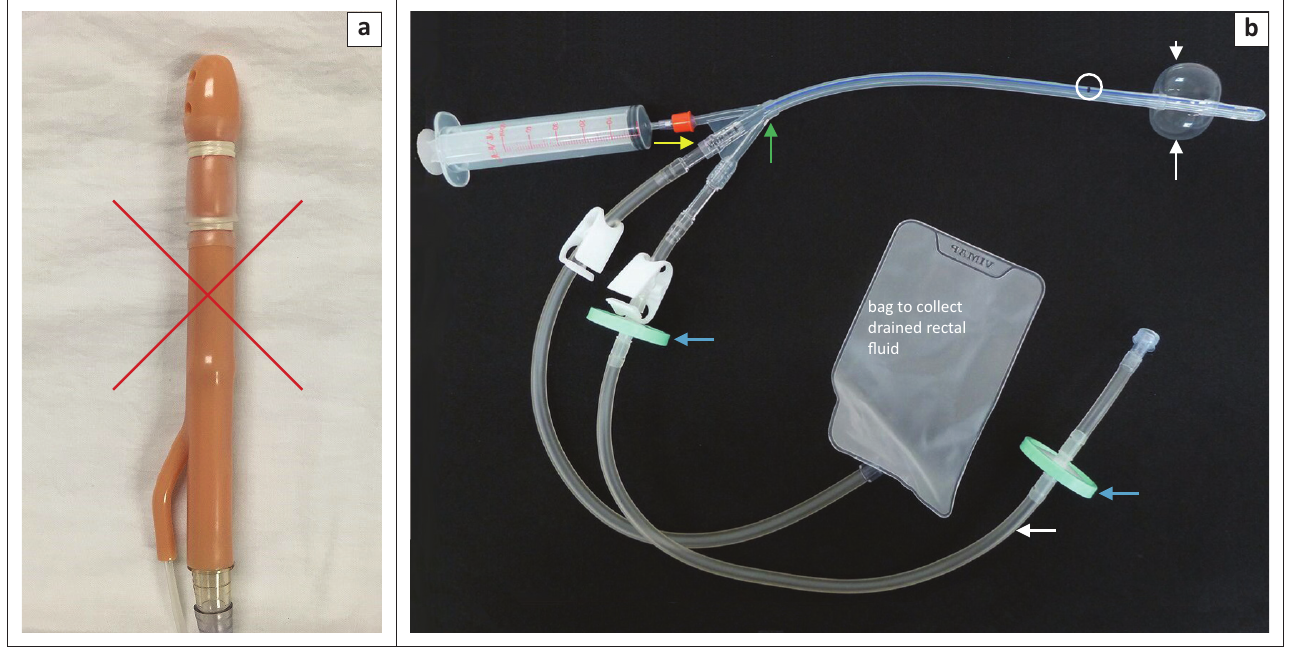
FIGURE 3: (a) Hard catheter is unsuitable as it may cause perforation; (b) Green arrow indicates trifurcation of tube and attached syringe for balloon distension; Yellow arrow indicates rectal drainage bag. White arrow indicates connection to CO insufflator. White circle shows black indicator line. The catheter must not be inserted into the rectum beyond 2 the black line (white circle). Inflated balloon (white arrows). Blue arrows indicate two green filters to trap any faecal fluid from entering and contaminating the CO